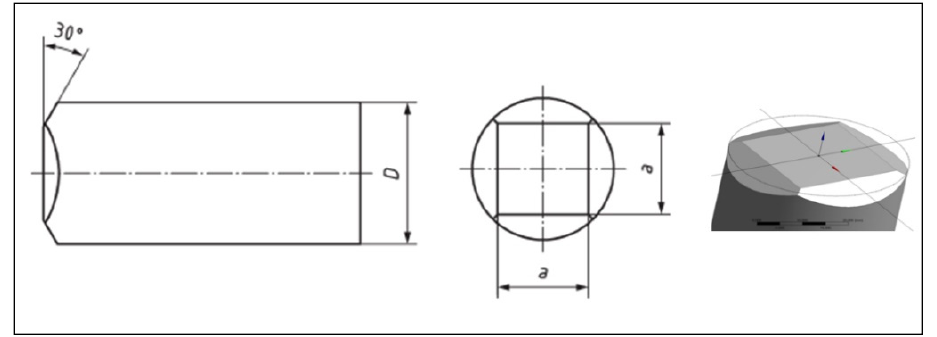
Figure 3. Standard projectile with 3D view of the shaped head. Table 1. Standard projectile specifications.